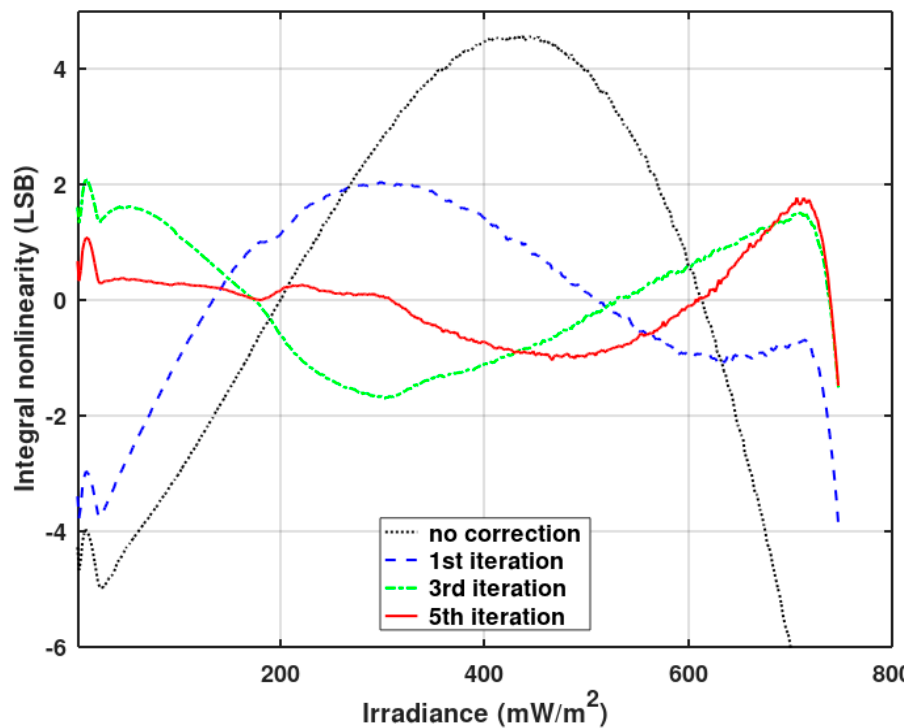
Figure 13. The results of the initial iterations of the linearity correction (with the gain and offset correction disabled). The measured INL is an average of 128 pixels.